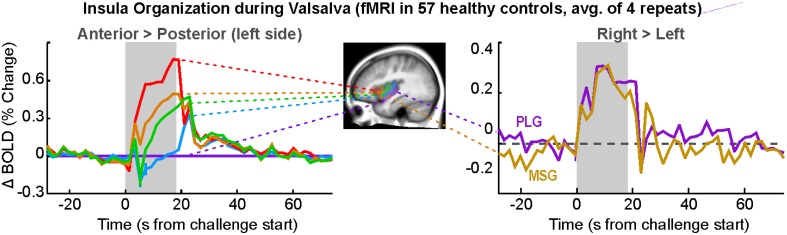
Insular gyri organization during responses to Valsalva maneuver (simplification of findings in Macey et al., 2012). Left: gyral activation relative to posterior-most gyrus (posterior long gyrus; PLG) on the left side, with anterior-most gryi showing great activation over posterior areas. Right: greater activation in right over left insular cortex in anterior and posterior gyri (mid short gyrus [MSG], PLG). Differences are significant (P < 0.05; Data from Macey et al., 2012).